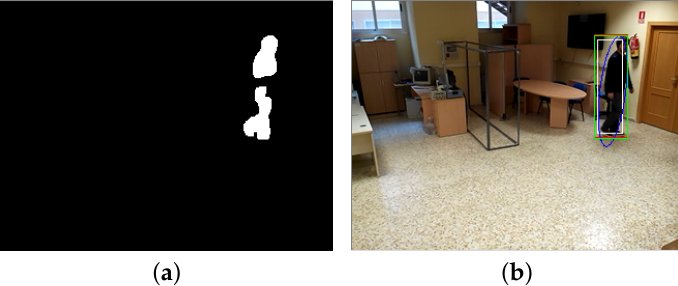
Figure 6. Broken contour reconstruction example. ( a ) image with separated contours; ( b ) image with reconstructed